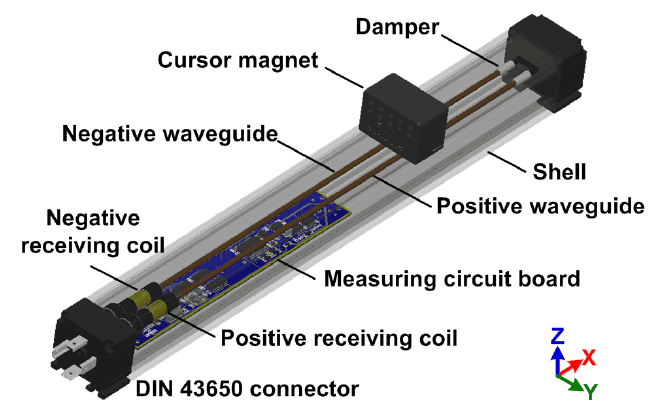
Figure 3. Proposed differential waveguide structure of